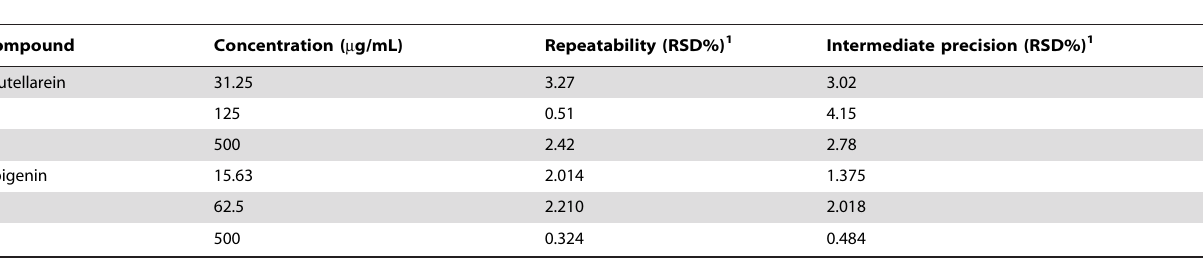
Table 3. Repeatability and intermediate precision data for the determination of scutellarein and apigenin by HPLC.